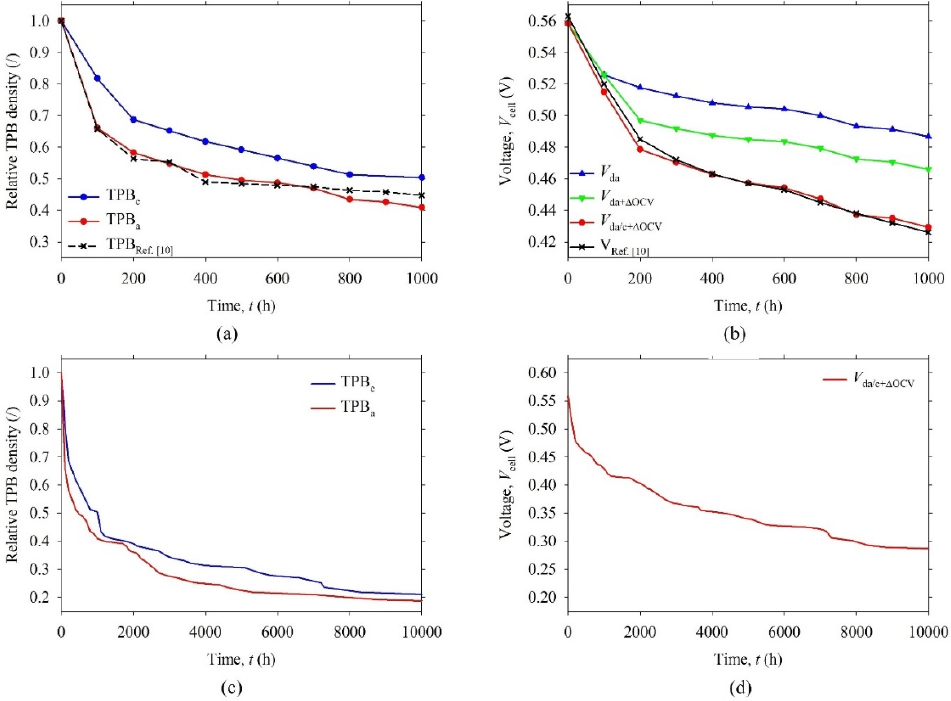
Figure 7. ( a ) Relative TPB density and ( b ) output voltage ( V cell ) of the SOFC as a function of time from 0 to 1000 h. ( c ) Relative TPB density and ( d ) output voltage ( V cell ) of the SOFC as a function of time from 0 to 10,000 h. The anode and cathode exponential coe ffi cients, κ a = 3 and κ c = 3, and the anode and cathode growth coe ffi cients, k a = 2.1 × 10 − 21 m 3 h − 1 and k c = 1.4 × 10 − 21 m 3 h − 1 , are